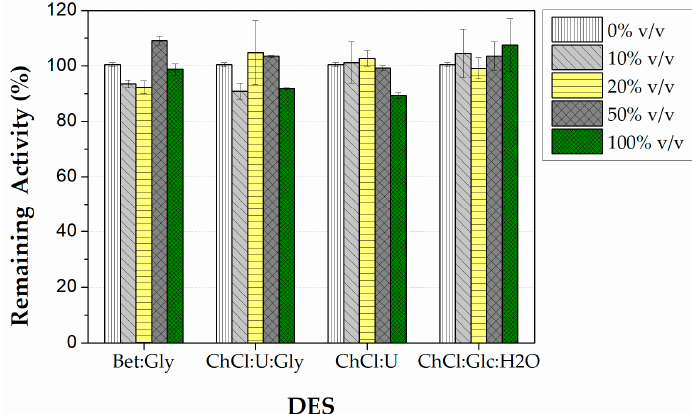
Figure 5. Stability of immobilized CALB on PLA wells after 1h of incubation at different concentrations (0–100% v / v ) of particular DESs at 40 °C. One hundred percent is defined as the initial activity (before the incubation) in buffer (0% v / v DES). Reaction conditions: 0.25 mM pNPB in 50 mM phosphate buffer pH 7.5, 40 °C, reaction time 5 min.